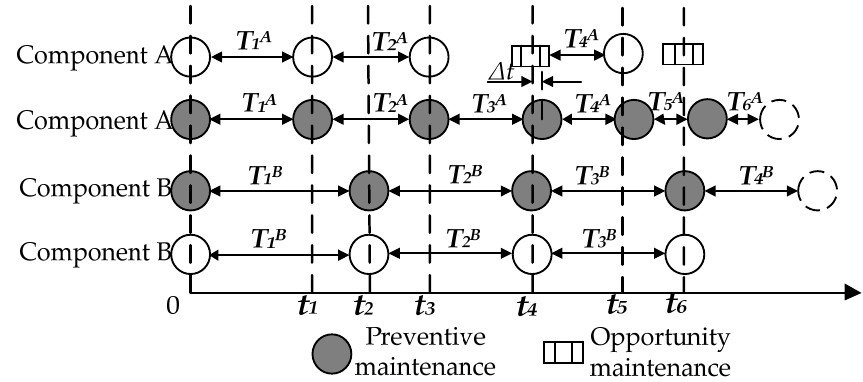
Figure 3. Schematic diagram of group preventive maintenance strategy.